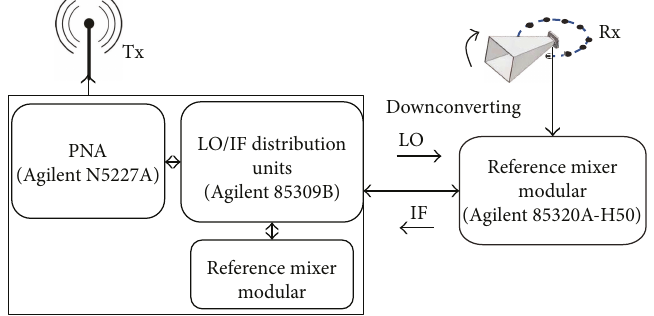
Figure 7: System overview of the measurement setup.